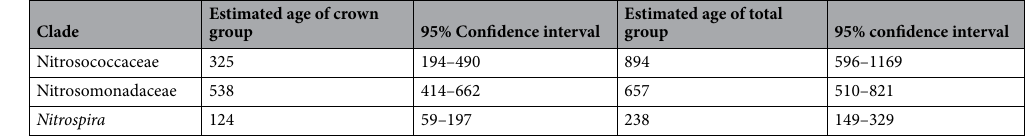
Table 1. Age ranges for key divergences discussed in the text in millions of years (Ma).